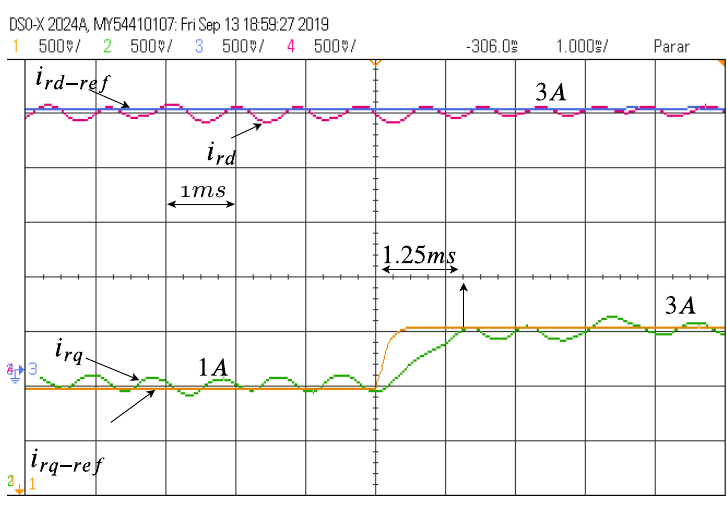
Figure 6. Step response of the experimental